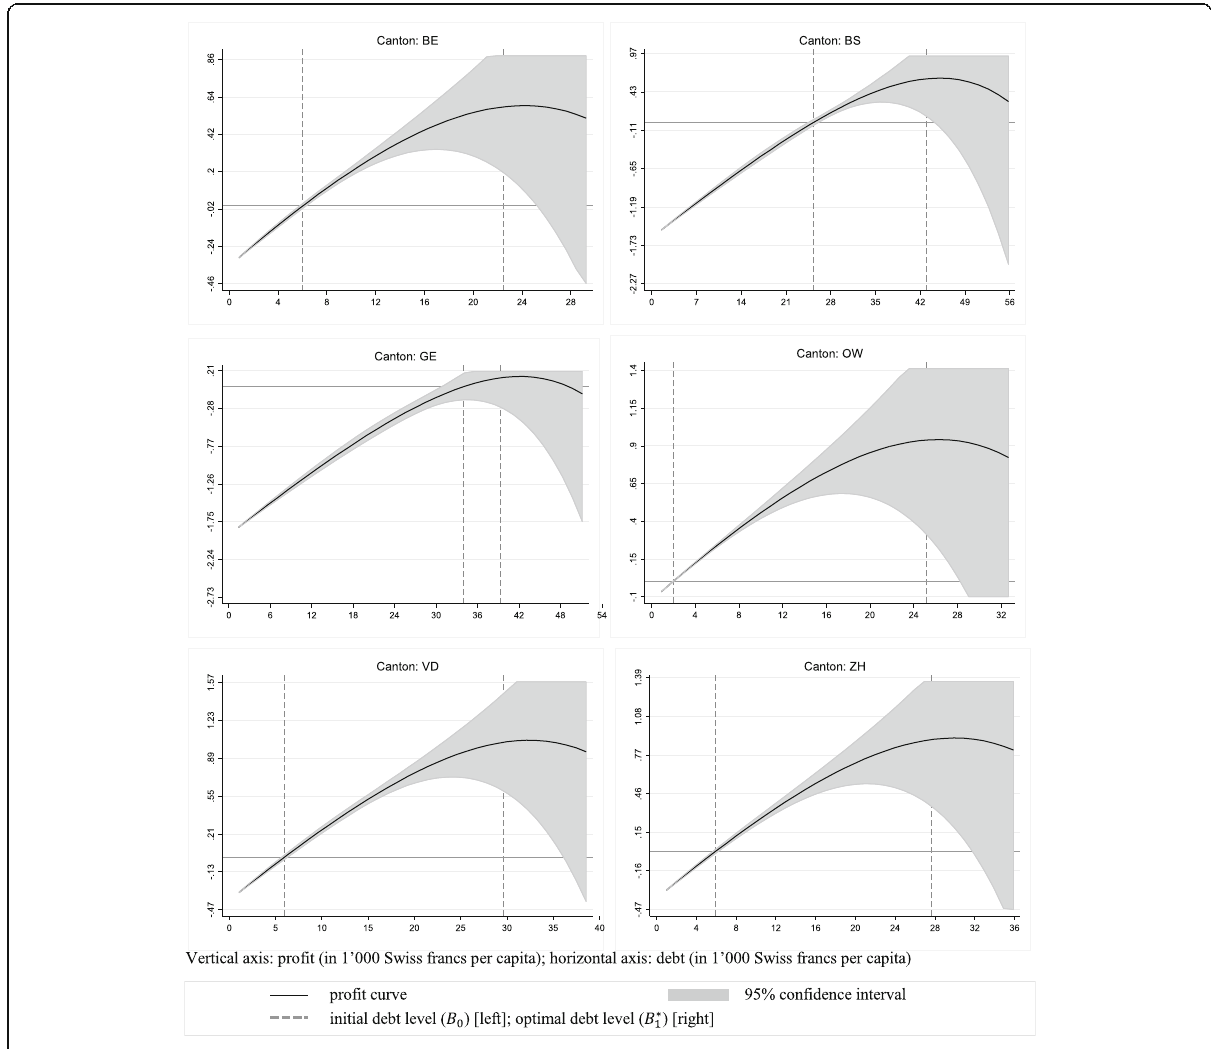
Fig. 2 Predicted profit curve from leveraged investments in